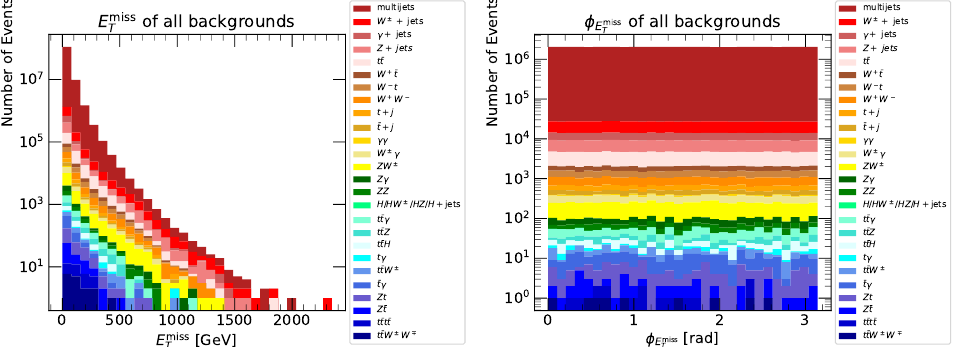
Figure 7: Missing transverse energy E miss